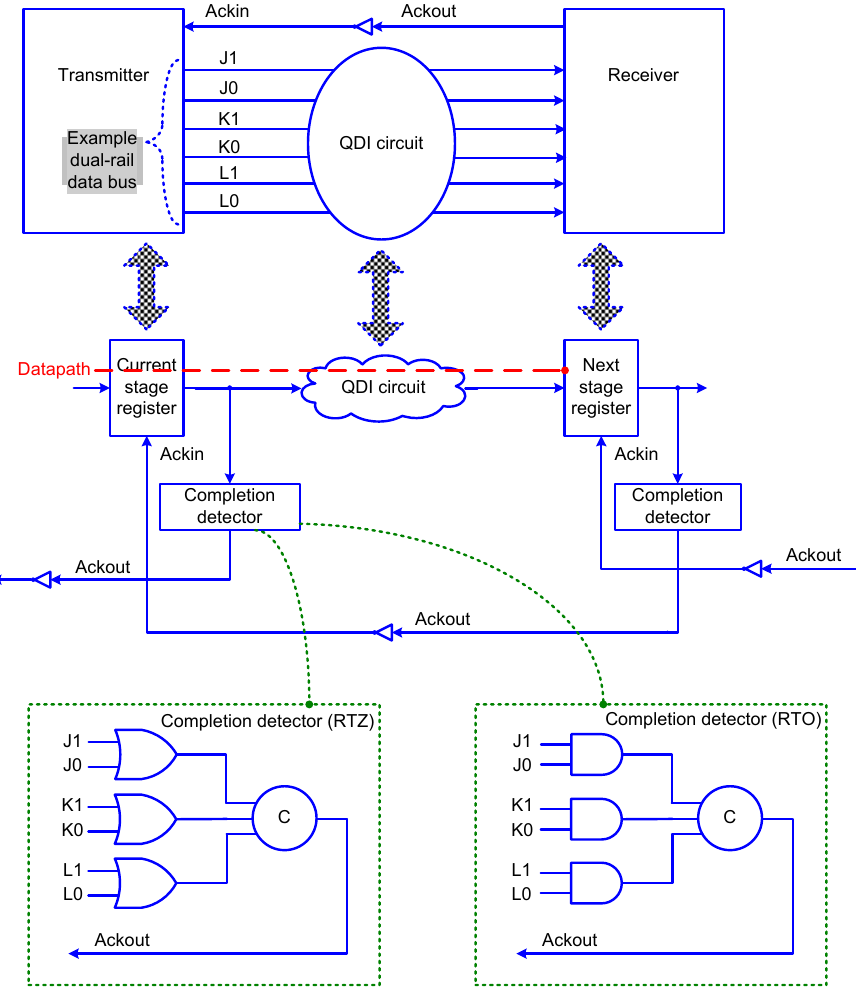
Figure 1. A quasi-delay-insensitive (QDI) circuit stage is correlated with the transmitter–receiver analogy. An example dual-rail data bus, represented by (J1, J0), (K1, K0) and (L1, L0) is used. The completion detectors corresponding to return-to-zero (RTZ) and return-to-one (RTO) handshake protocols are portrayed within the dotted green boxes. The datapath is highlighted by the red dashed line, traversing the current stage register and the QDI circuit. Ackin is the Boolean complement of Ackout and vice versa.